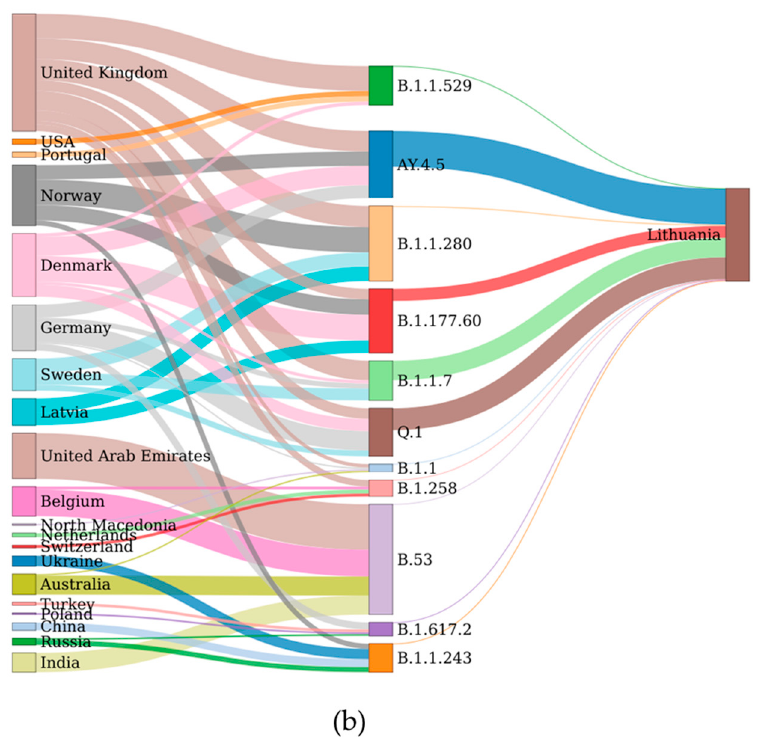
Figure 4 . The most likely countries of origin for the most prevalent lineages based on the GTR model. ( a ) The Y axis depict frequency of transmission to Lithuania from the listed countries, as inferred from the time-scaled phylogenetic trees. The upper graph depicts the cumulative frequencies across different lineages. The small graphs below give details of the top four countries with the largest observed transmission frequencies to Lithuania. ( b ) The columns in the middle of the Sankey diagram depict lineages. The widths of the flows to the left side of these columns are proportional to the frequency of transmission to Lithuania, as inferred from the time-scaled phylogenetic trees. The width of the flows to the right side of the columns in the middle are proportional to the fraction of all GISAID-deposited Lithuanian sequences matching a particular lineage.